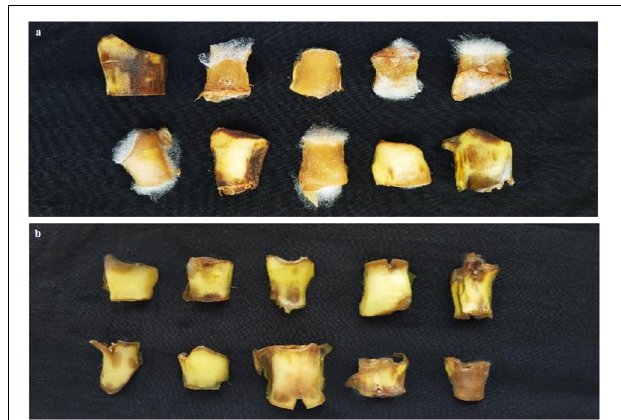
FIGURE 4 | Inhibition of pathogen in curing barn. The experiment was conducted in field conditions naturally infested with fungal pathogen R. oryzae . (a) Infested tobacco leaves with R. oryzae. (b) Effect of B. amyloliquefaciens Y2 was used as a biocontrol agent against R. oryzae under field